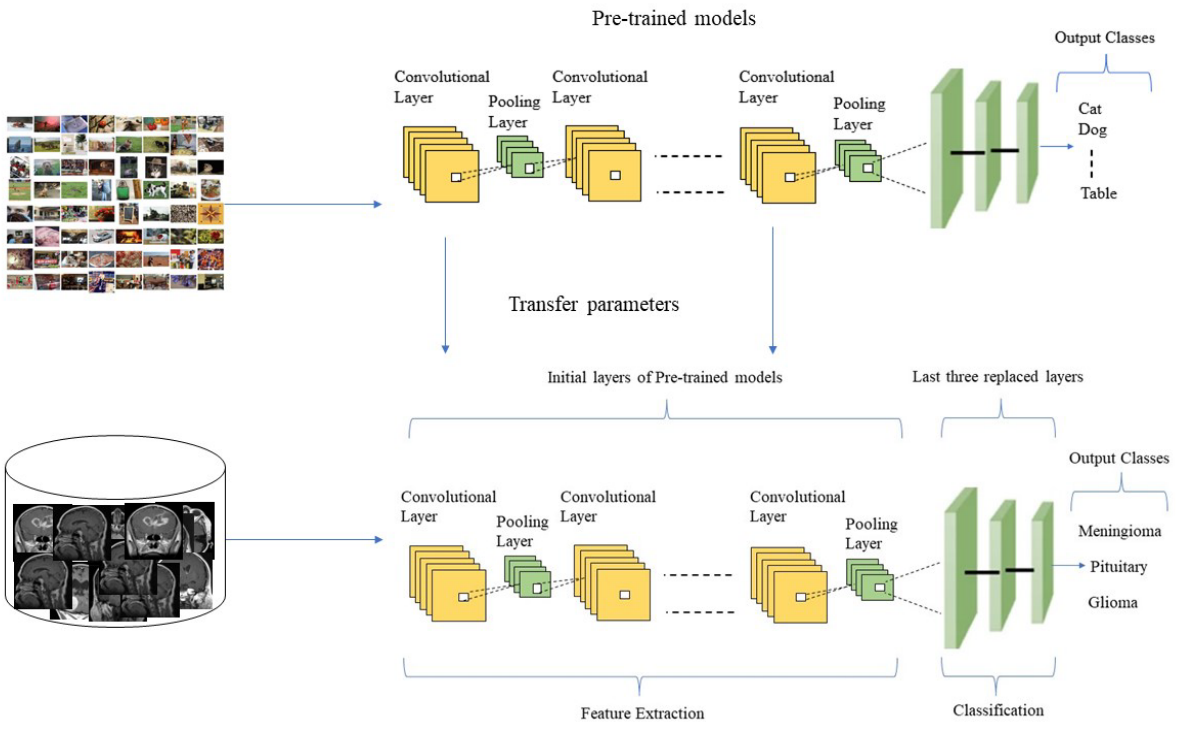
Figure 2. Transfer learning